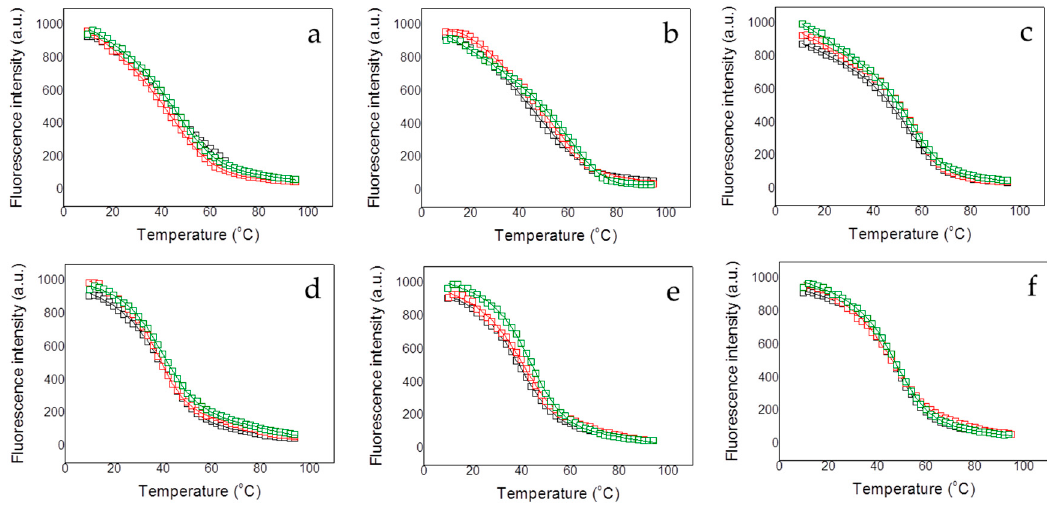
Figure 2. Fluorescence thermal denaturations for the MBD R106W ( a – c ), and MBD R133C ( d – f ) under di ff erent conditions. The influence of the pH was assessed (pH 7, black squares; pH 8, red squares; and pH 9, green squares) ( a , d ). The influence of the presence of dsDNA at pH 7 was assessed (absence of dsDNA, black squares; presence of unmethylated CpG-dsDNA, red squares; and presence of methylated mCpG-dsDNA, green squares) at pH 7 and low ionic strength ( b , e ) and high ionic strength ( c , f ). All unfolding traces could be fitted employing a two-state unfolding model (continuous lines) according to Equation (1).